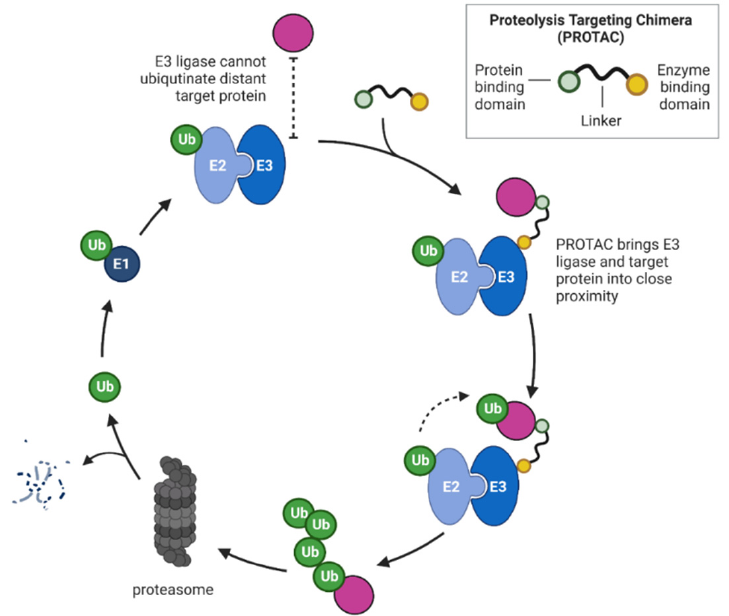
Figure 3. The mechanism of PROTAC-mediated targeted protein degradation. The PROTAC works as “molecular glue” and brings the target protein closer to E3 ligase to form a multi-protein complex. This result in Ub transfer from E2 to the target and subsequent degradation in the proteasome. Excluding the proteolyzed target, the classic component of the ubiquitination pathway and PROTAC recycle during the whole